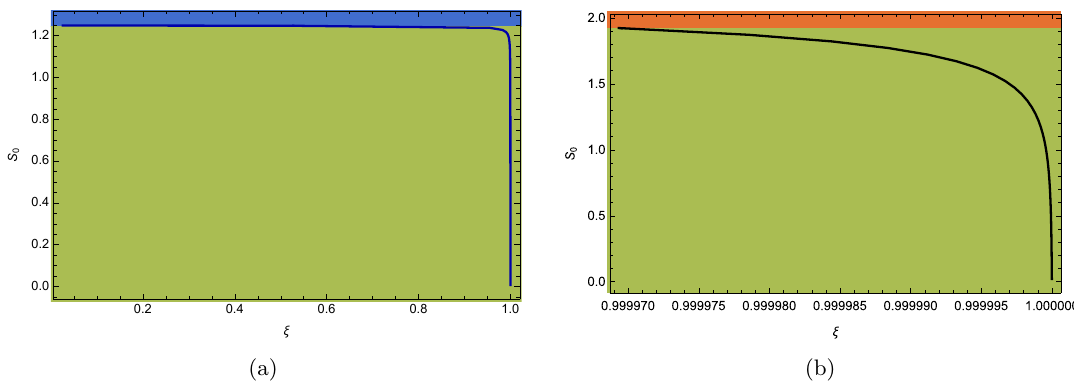
Figure 21 . The ratio of the couplings vs S 0 for the two typical blue and black curves shown in figure